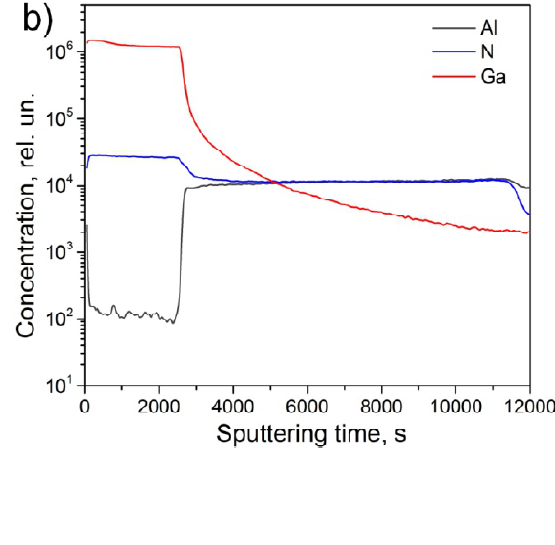
Fig. 5. Concentration profiles of Al, Ga, and N as a function of sputtering time obtained by SIMS for samples (a) A, (b) D and (c)